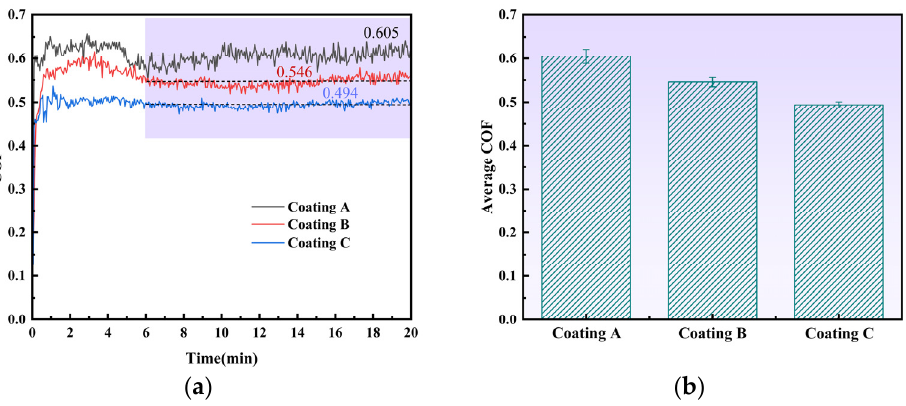
Figure 12. ( a ) Friction and wear curves of different coatings; ( b ) average COF.